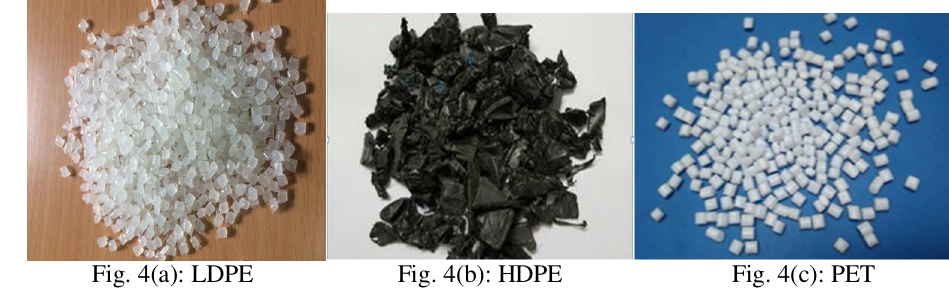
Fig. 3: Master Curve of PG 58-22 Penetration Grade Bitumen